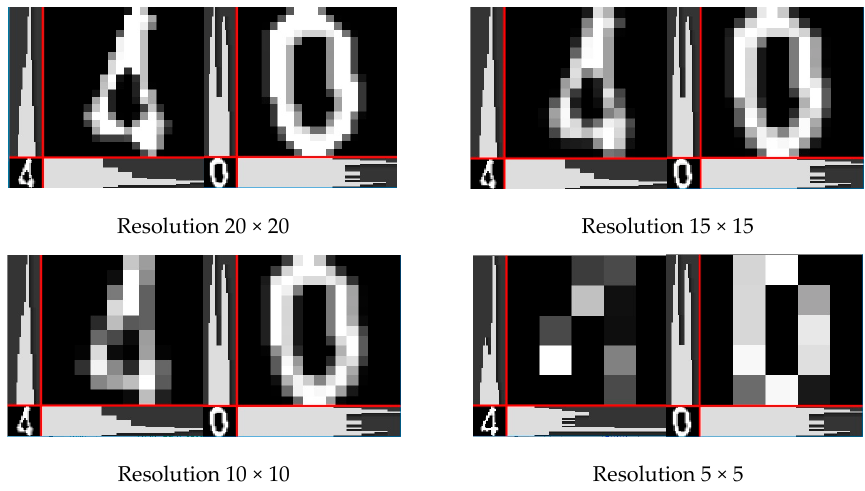
Figure 15. Three feature quantities at each resolution for the extracted number 40.